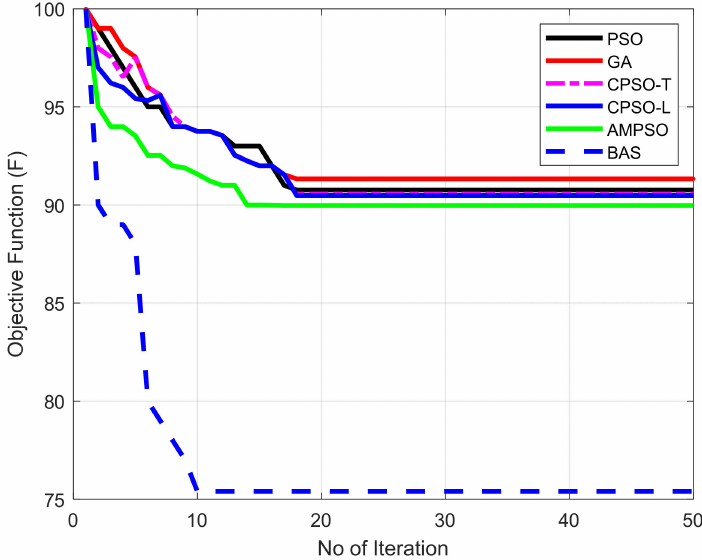
Figure 12. Comparison of convergence characteristics of the objective function with different algo- rithms.